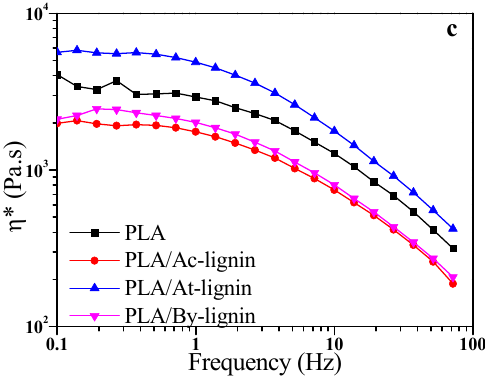
Figure 16. Frequency ramp sweep curves for pure PLA, PLA/Ac-lignin, PLA/At-lignin, and PLA/By- lignin biocomposites: ( a ) Storage modulus ( G ′ ), ( b ) loss modulus ( G ″ ), ( c ) complex viscosity ( η *).